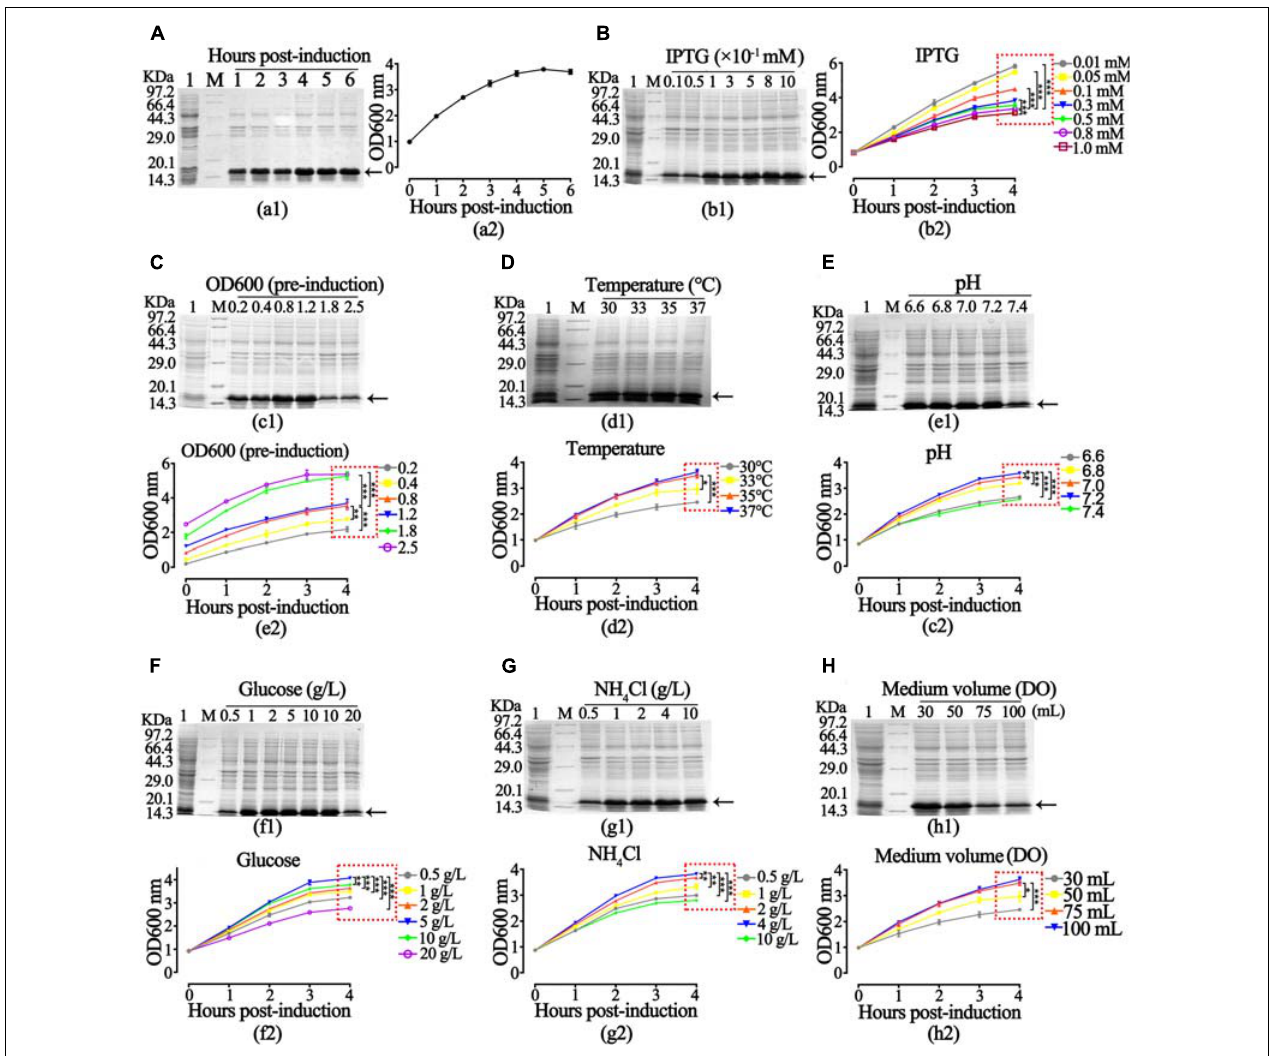
FIGURE 3 | Optimization of expression parameters of rhaFGF 135 E. coli strain in 30 mL LB medium. (A) The expression level of rhaFGF 135 (a1) and bacterial density represented by OD 600 (a2) induced by 0.8 mM IPTG for 1–6 h. (B) The expression level of rhaFGF 135 (b1) and bacterial density (b2) after induction with 0.01–1.0 mM IPTG for 1–4 h. (C–H) The expression level of rhaFGF 135 and bacterial density induced by 0.8 mM IPTG for 1–4 h under different conditions, including (C) pre-induction bacterial density (OD 600 ), (D) temperature at 30, 33, 35, and 37 ◦ C, (E) pH in the range of 6.6–7.4, (F) glucose concentrations in the range of 0.5–20 g/L, (G) NH 4 Cl concentrations in the range of 0.5–10 g/L, and (H) medium volume (30, 50, 75, and 100 mL). Lane 1, non-induced. Lane M, molecular weight marker. All of the experiments were performed in 250 mL shake flask. Black arrows indicate rhaFGF 135 protein. Asterisks indicate significant differences (* p < 0.05, ** p < 0.01, *** p < 0.001, n =